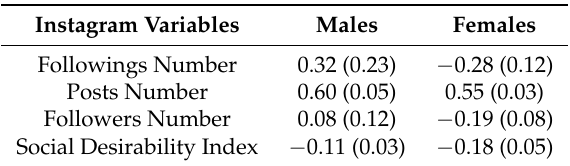
Figure 1. Effect of participants’ gender on each standardized Instagram variable. Bar plots are reported according the following order: ( A ) number of followings; ( B ) number of posts; ( C ) number of followers; ( D ) Social Desirability Index (* p < 0.0125). Table 4. Mean values in male and female participants on the overall Instagram variables. Standard Error Means (SEM) are reported between